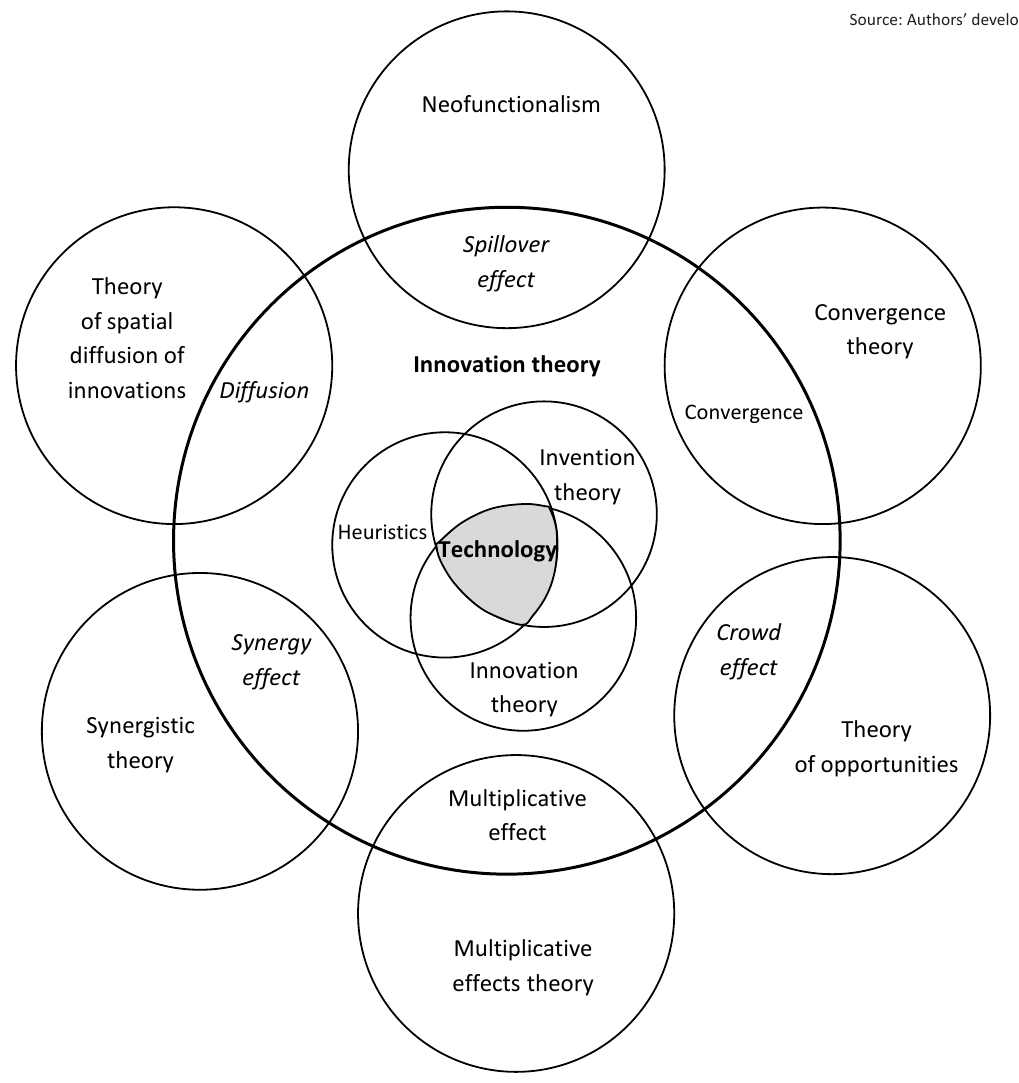
Figure 3. Mutual influence of theories within the technology